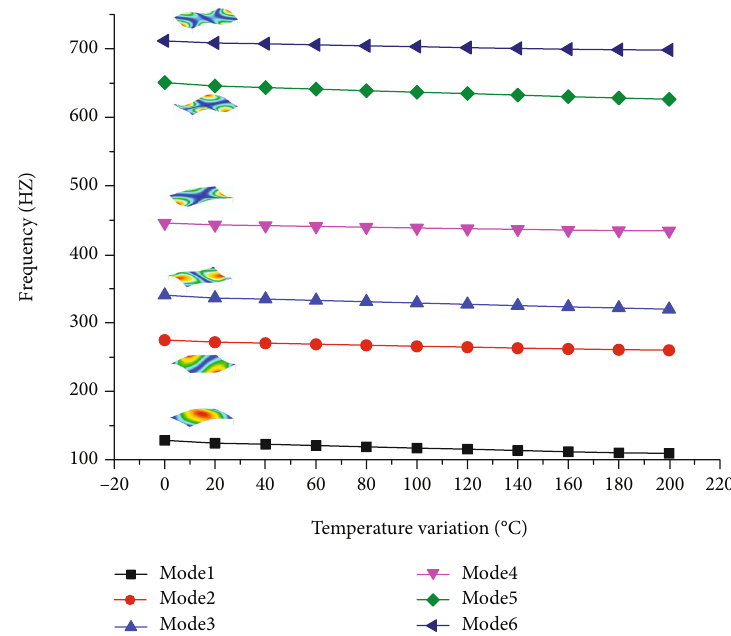
Figure 14: Frequency change curve with temperature variation for point C.